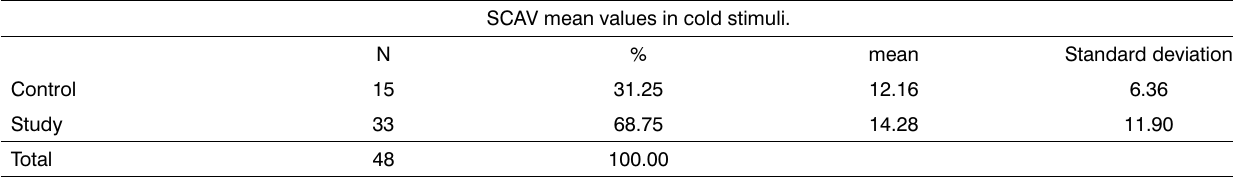
Table 3. SCAV mean nystagmus values in cold stimulation in all individuals tested.